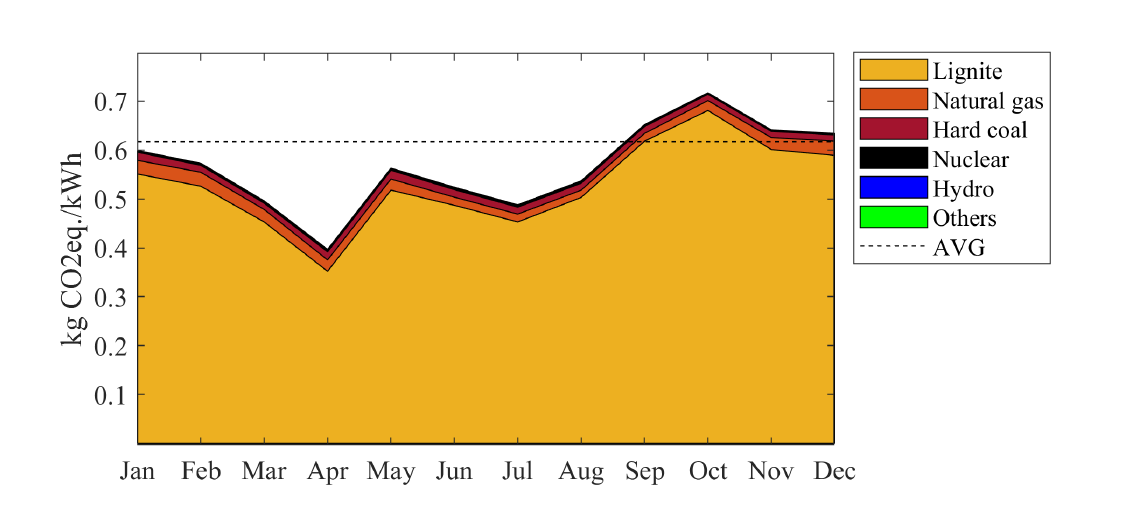
Figure 3. Monthly peak hours GWP compared with average through the year (dotted line) in Bulgaria.